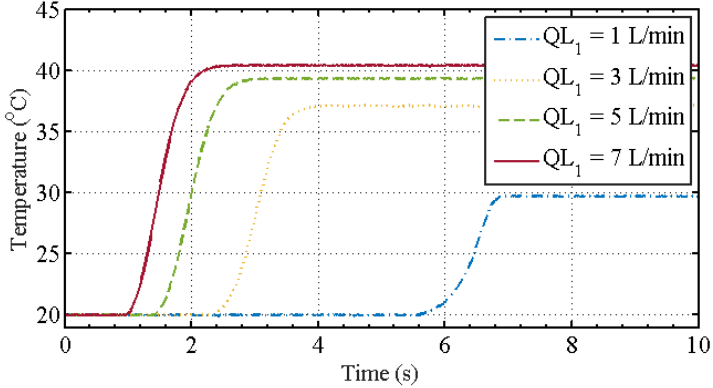
Figure 26. The output temperature in cold fluid with QL 2 = 1 L/min.